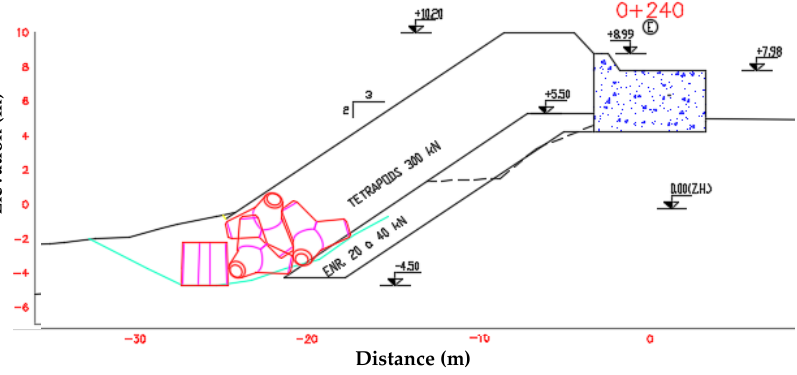
Figure 2. Ericeira’s breakwater quay section.